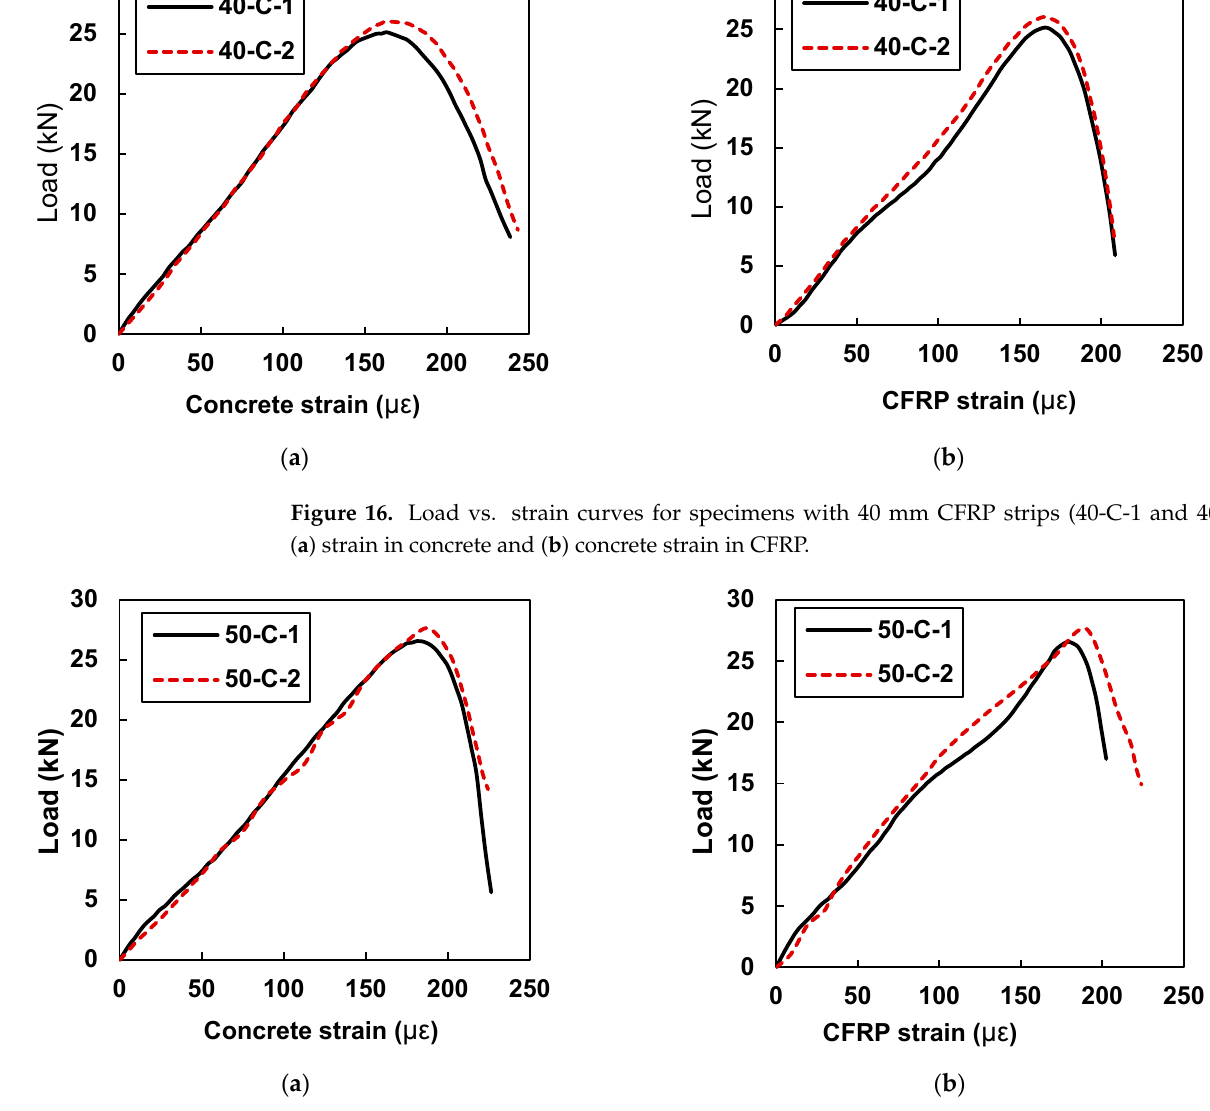
Figure 17. Load vs. strain curves for specimens with 50 mm CFRP strips (50-C-1 and 50-C-2): ( a ) strain in concrete and ( b ) concrete strain in CFRP.